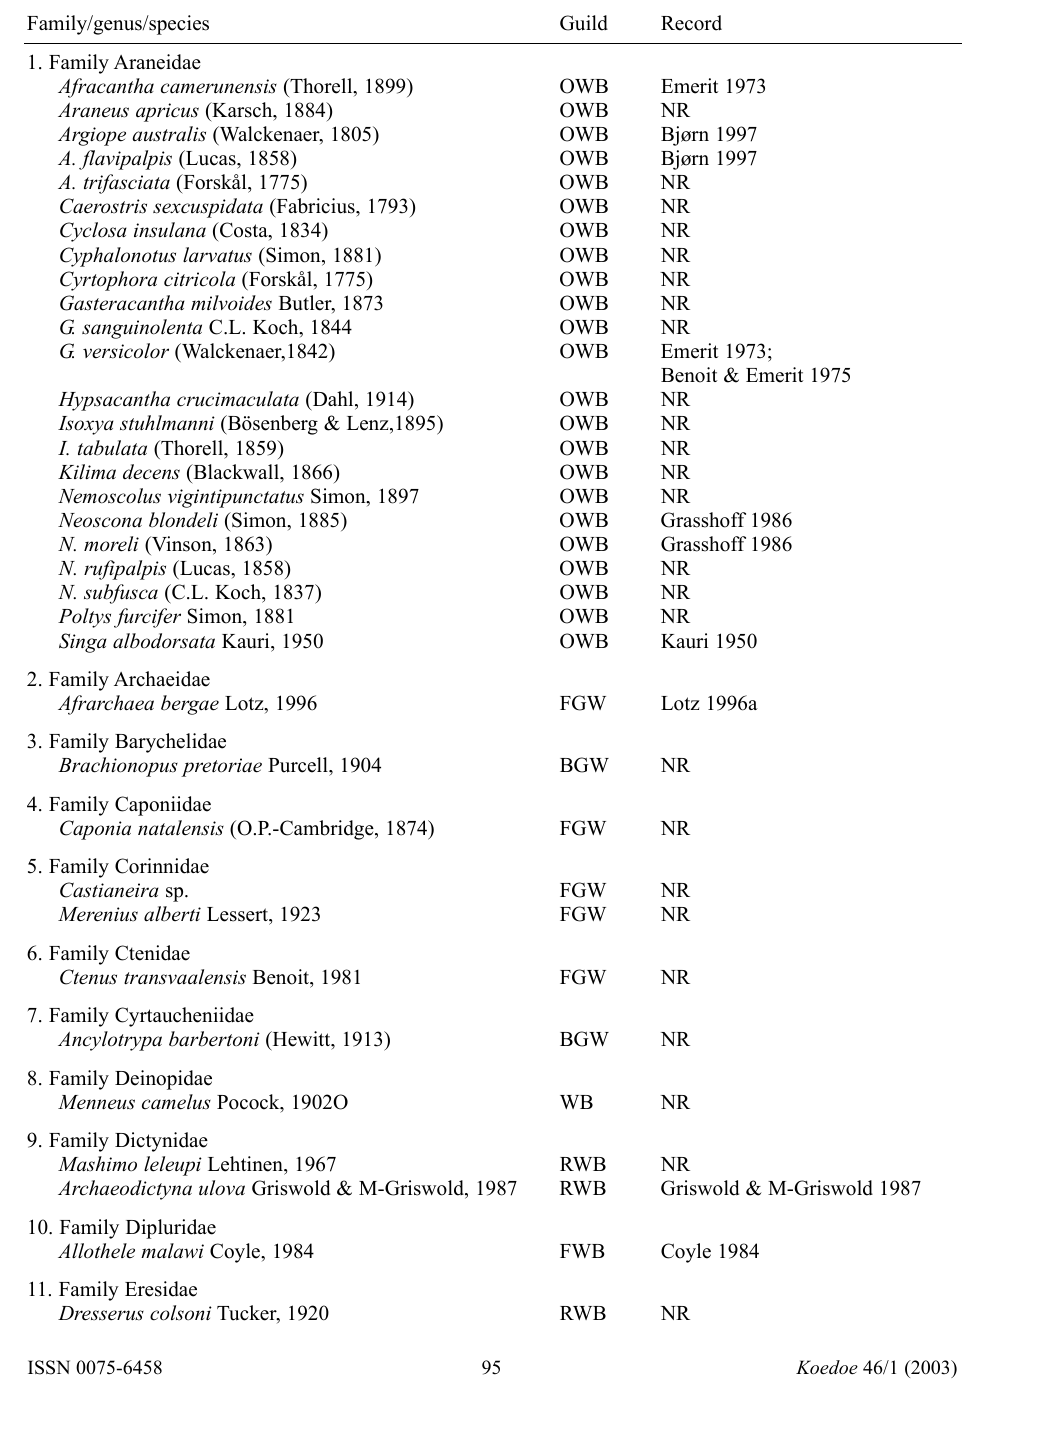
Check list of the spiders of the Kruger National